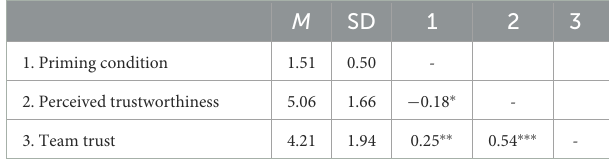
TABLE 1 Means, standard deviations, and correlations ( N =